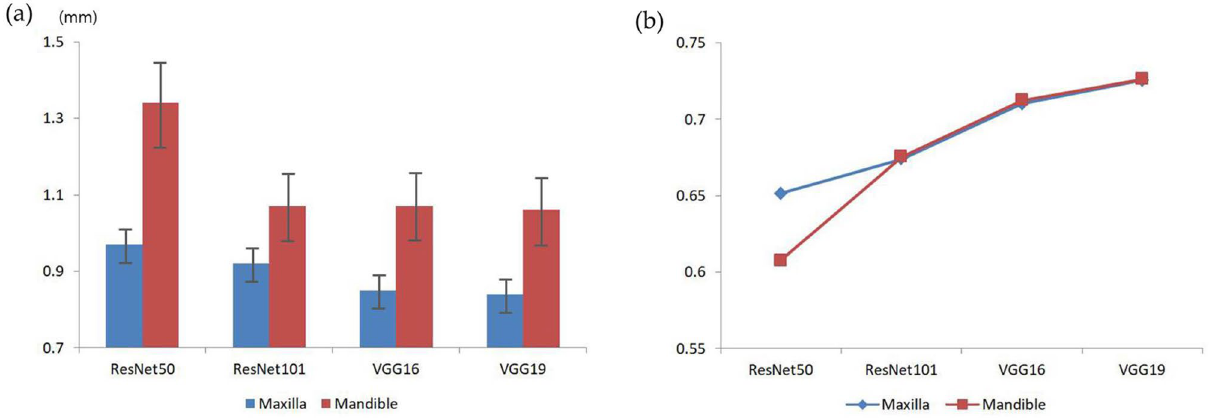
Figure 3. Mean errors and weighted kappa coefficients of landmark detection with crowding categorization. ( A ) The maxilla models consistently show smaller error values than the mandible ones. The mean errors decrease in the order of ResNet50, ResNet101, VGG16, and VGG19. ( B ) All kappa values suggest that the strength of agreement for crowding classification is substantial, and the agreement becomes higher as the layer becomes deeper in the same network